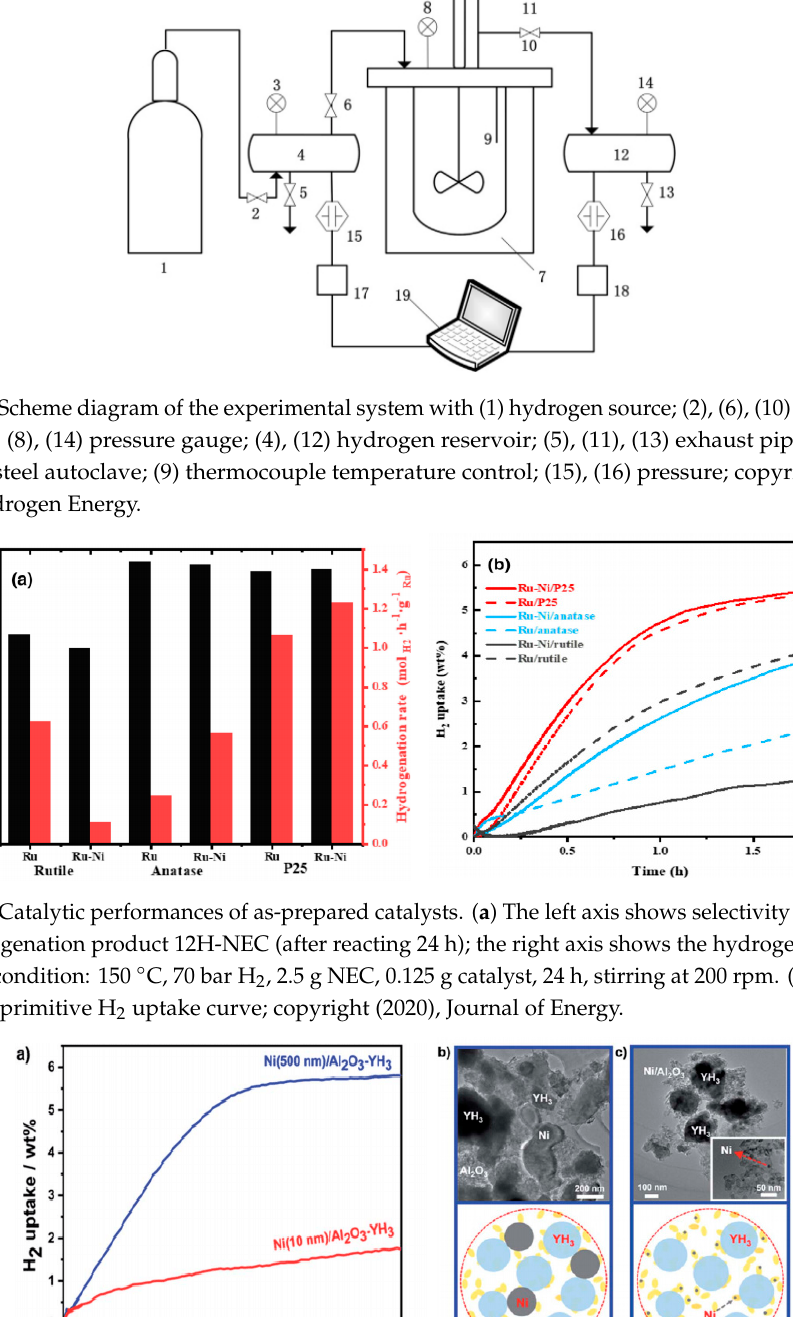
Figure 1. Scheme diagram of the experimental system with (1) hydrogen source; (2), (6), (10) connection valve; (3), (8), (14) pressure gauge; (4), (12) hydrogen reservoir; (5), (11), (13) exhaust pipe valve; (7) stainless steel autoclave; (9) thermocouple temperature control; (15), (16) pressure; copyright (2012), Int. J. Hydrogen Energy.